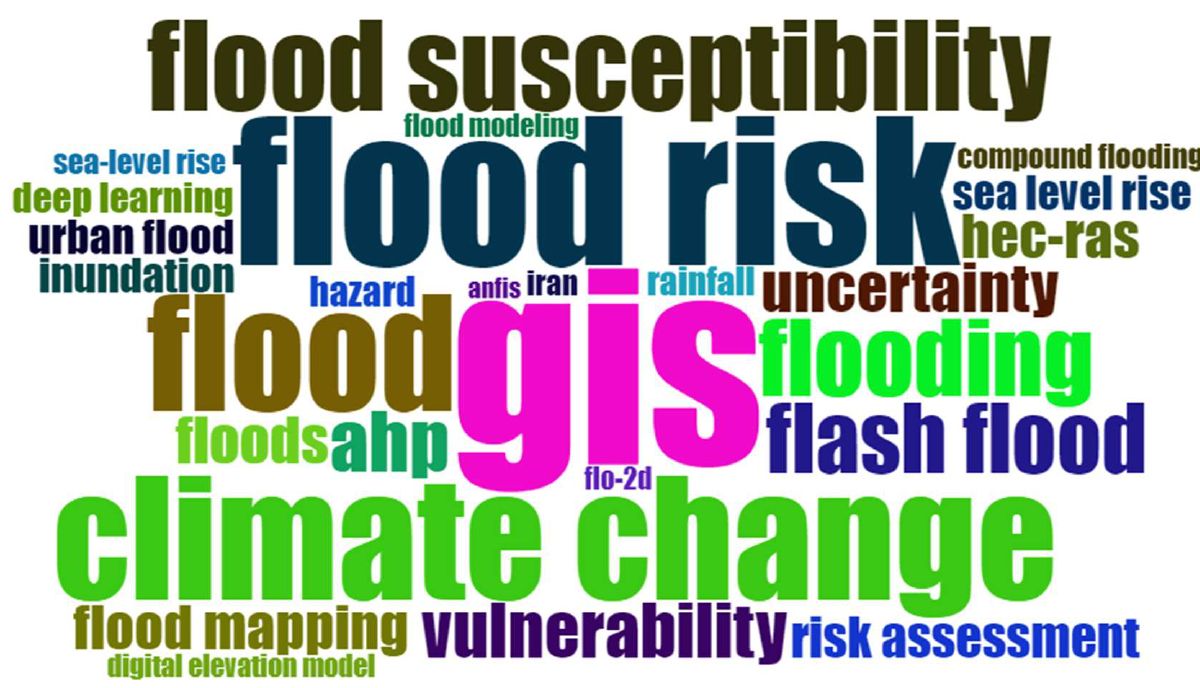
Figure 6. Word cloud.